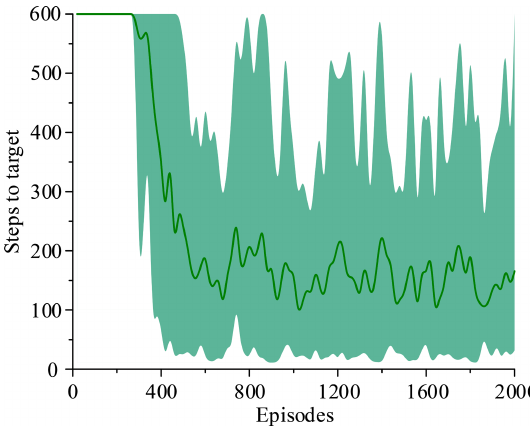
Figure 17. The steps to target with states descriptor